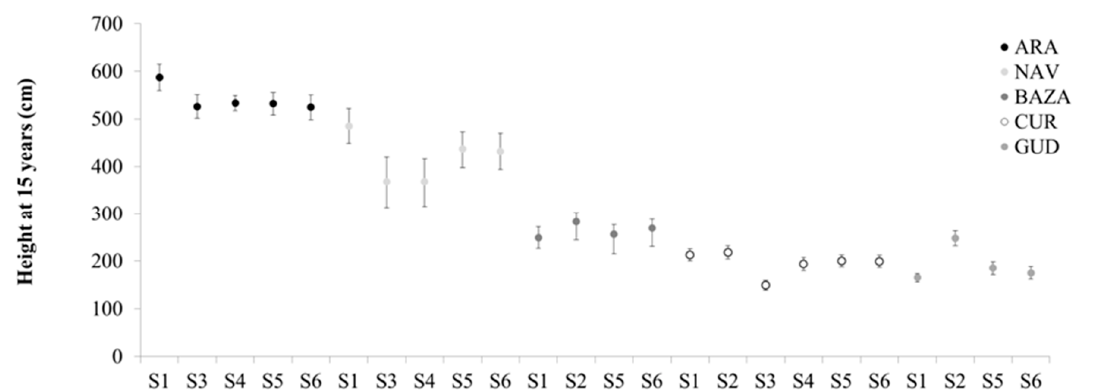
Figure 3. Values for the different scenarios of the Height at 15 years in the different sites. [Code for